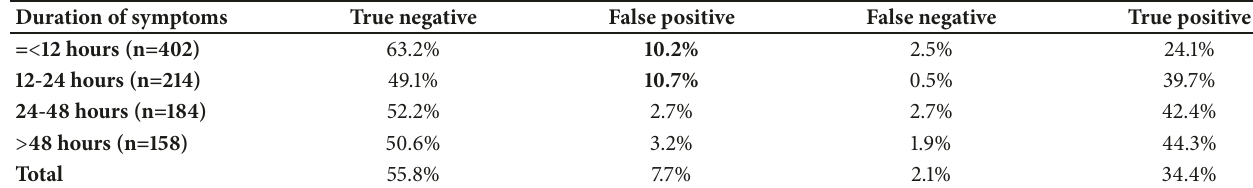
Table 5: Relation between duration of symptoms and accuracy of the New Scoring System